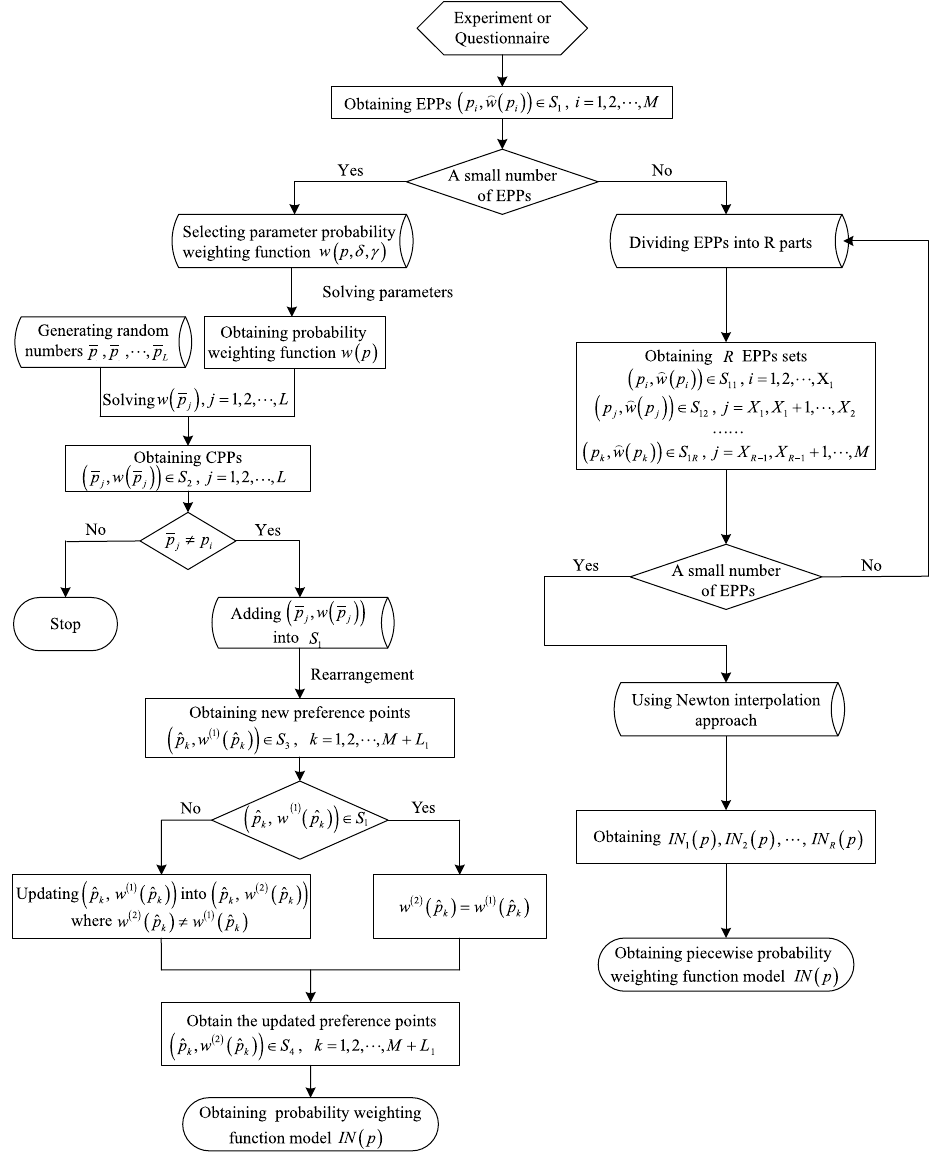
Figure 5. Building model flow